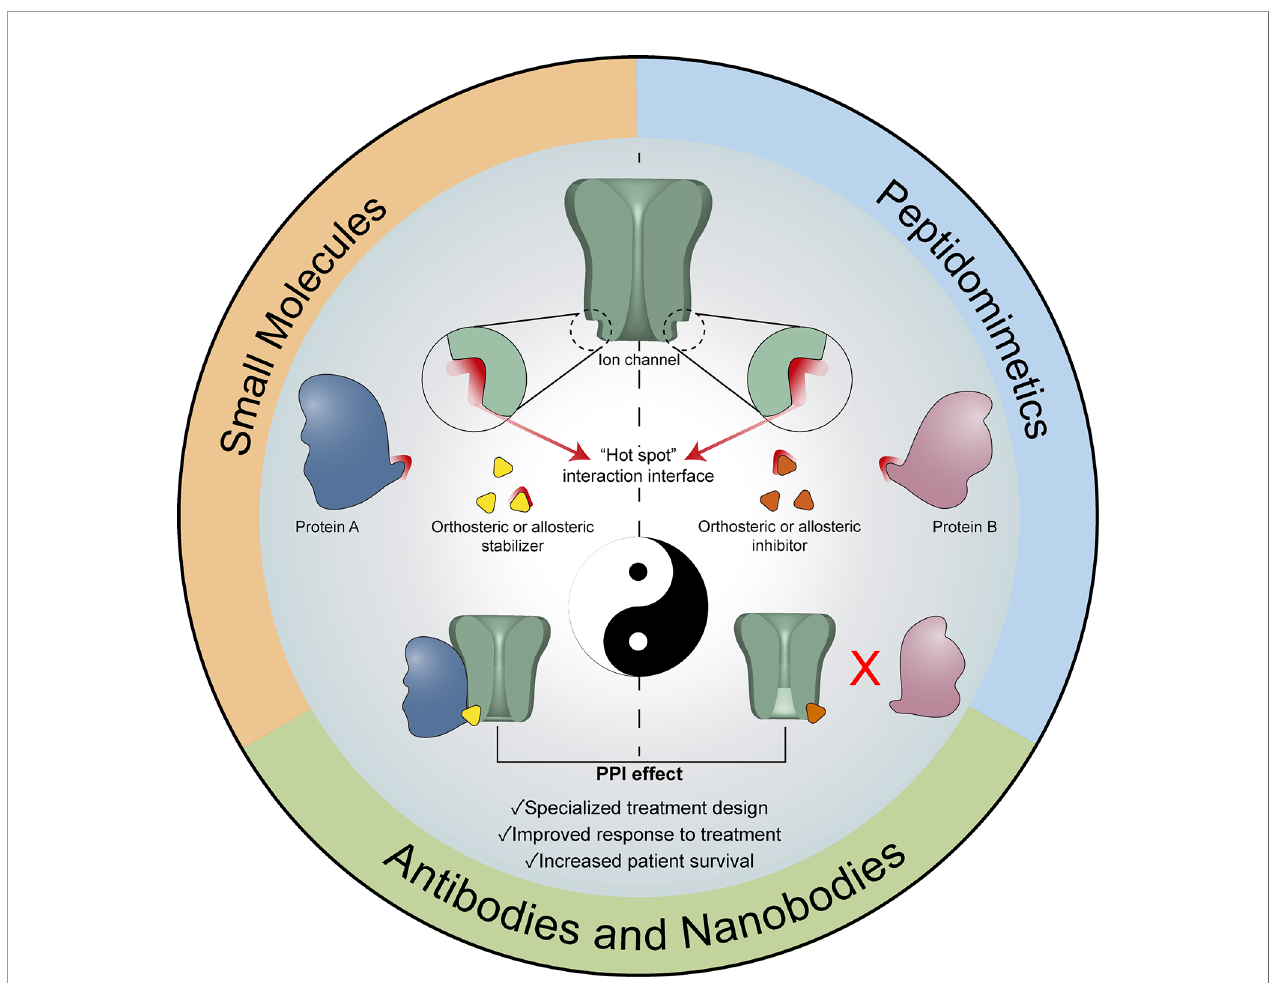
FIGURE 2 | Modulation of ion channel-associated PPIs as therapeutic tool. Graphical representation of the modulation options for Ion channel-associated PPI, either through stabilizers or inhibitors of the interactions. All these strategies could constitute a useful complementary therapeutic tool contributing to increasing existing or personalized